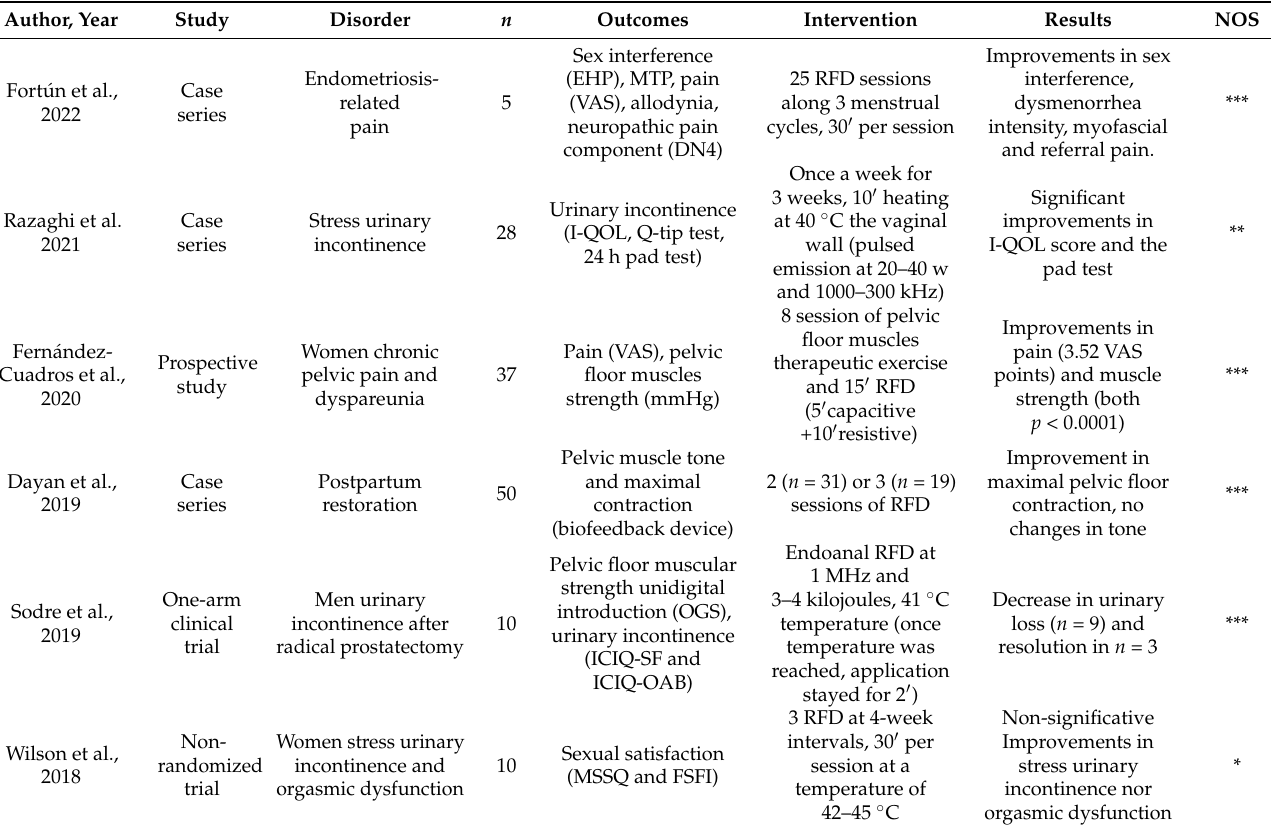
Table 3. Summary of the other design of studies considered of